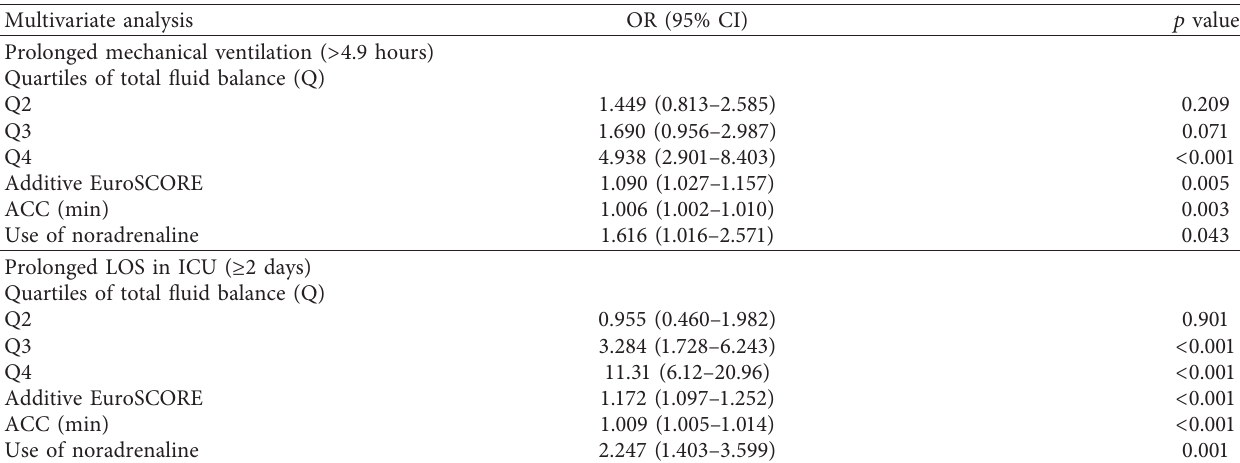
Table 4: Multivariate